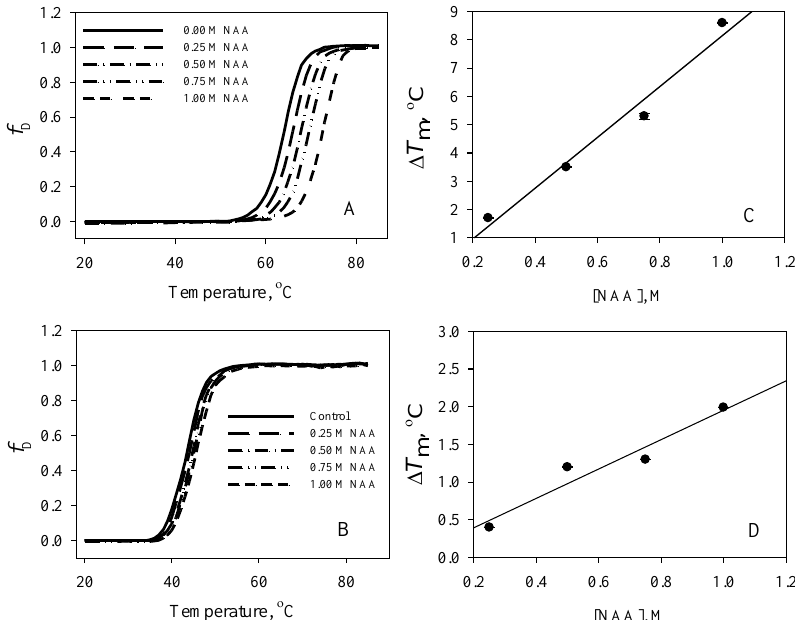
Figure 1. Thermal denaturation profiles of Ribonuclease-A (RNase-A) at pH 7.0 and pH 2.5. Left panels: Denaturation curves of RNase-A at pH 7.0 ( A ) and at pH 2.5 ( B ) in the absence and presence of various N-Acetylaspartate (NAA) concentrations. Right panels: Plots of ∆ T m versus NAA of RNase-A at pH 7.0 ( C ) and at pH 2.5 ( D ).The protein concentration used was 31µM.